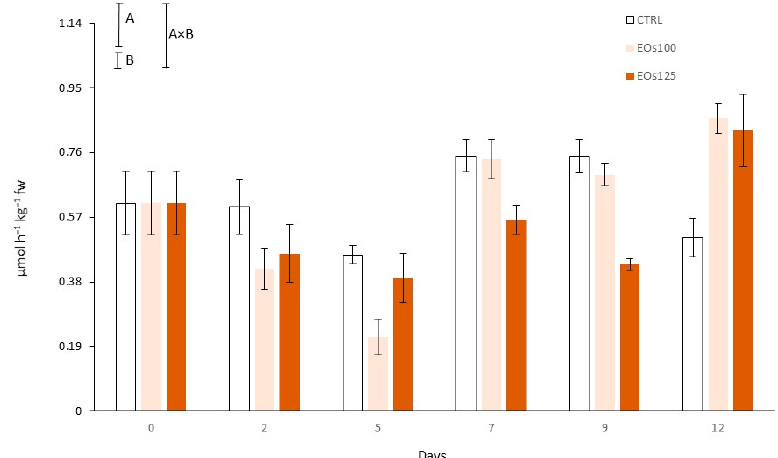
Figure 5. Phenyl ammonia lyase activity of sliced mushroom during cold storage (4 °C) under modified atmosphere packaging supplemented with vapour essential oils (100 and 125 µ L L − 1 EOs) (mean ± standard deviation). Least significant differences are represented as bars, with A and B letters for the treatment and storage time factors, respectively.